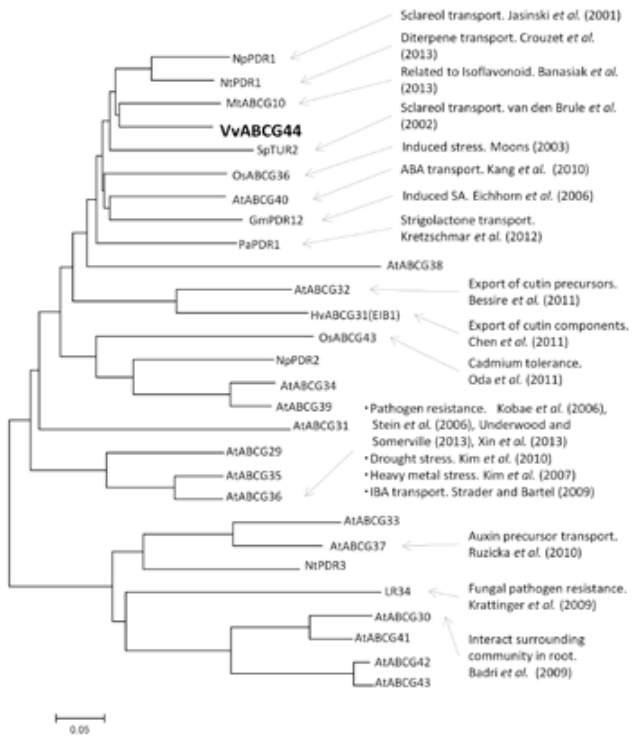
Fig. 2 - Phylogenetic tree of all full-size ABCGs in Arabidopsis , VvAB- CG44 , and characterized full-size ABCGs from various plant species. NpPDR1 and NpPDR2 from Nicotiana plumbaginifo- lia , NtPDR1 and NtPDR3 from tobacco, SpTUR2 from Spiro- della polyrhiza , OsABCG36 and OsABCG43 from rice, Hv- ABCG31 from barley, PaPDR1 from Petunia, Lr34 from wheat, and GmPDR12 from soybean. The neighbor-joining tree was constructed with MEGA5 (Tamura et al .,